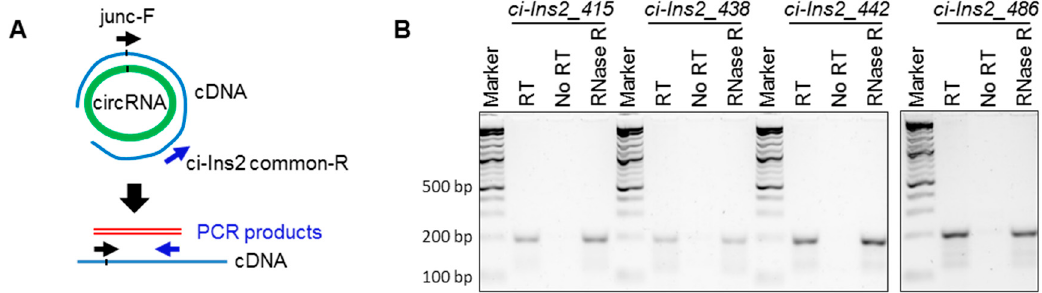
Figure 4. Multiple ci-Ins2 transcripts are expressed in β TC6 cells. ( A ) Schematic representation of RT-PCR verification of circular RNAs, with the forward primer spanning the backsplice junction. Green circle represents the circRNA template, the blue line represents cDNA, arrows represent the PCR primers, and the red line represents expected PCR products. ( B ) PCR products of individual circular RNAs in β TC6 cells total RNA cDNA (RT), no-RT, and RNase-R-treated samples were resolved on 2.5% agarose gel stained with SYBR-Gold.